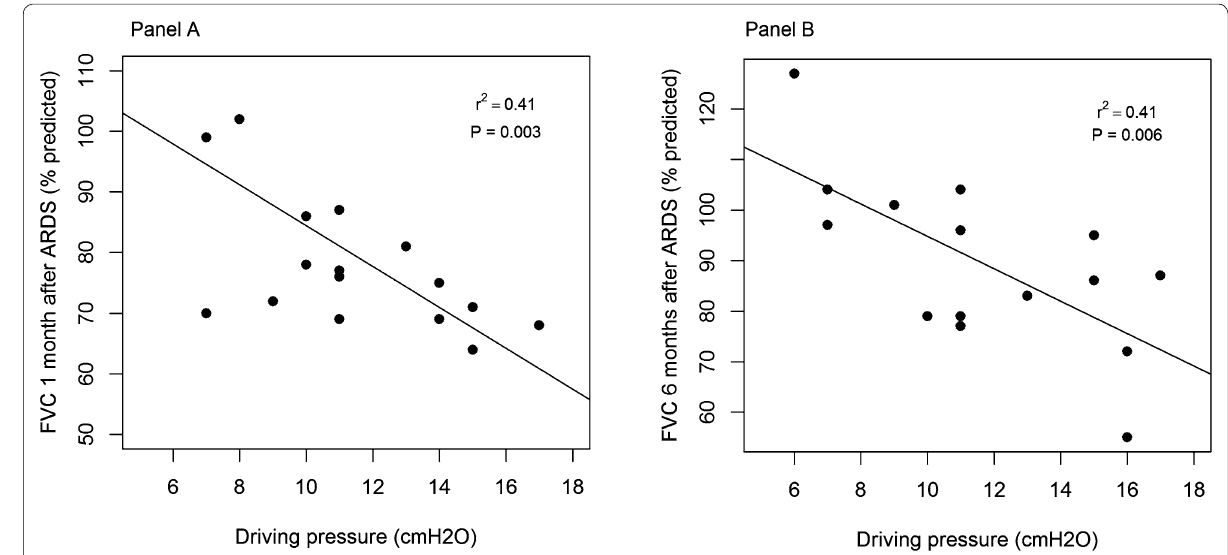
Fig. 2 Relationship between driving pressure and forced vital capacity after 1 month (panel A) and 6 months (panel B) of acute respiratory distress syndrome